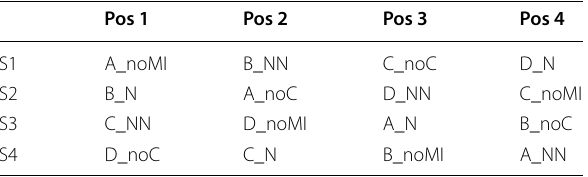
Table 1 Presentation sequences (S1–4) used in